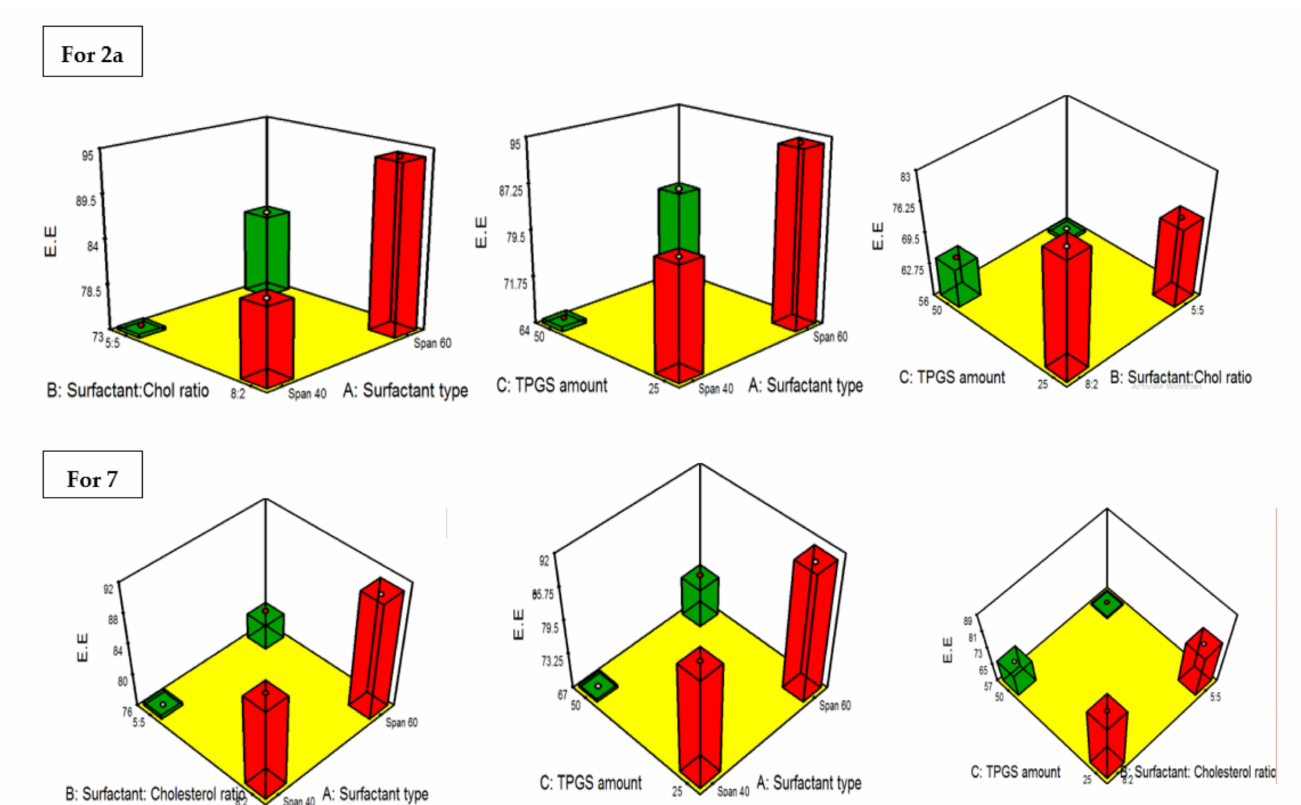
Figure 14. Three-dimensional surface response plots exploit the impact of ( A ) surfactant type, ( B ) sur- factant:cholesterol ratio and ( C ) TPGS amount on EE% of 2a and 7-loaded TPGS-coated